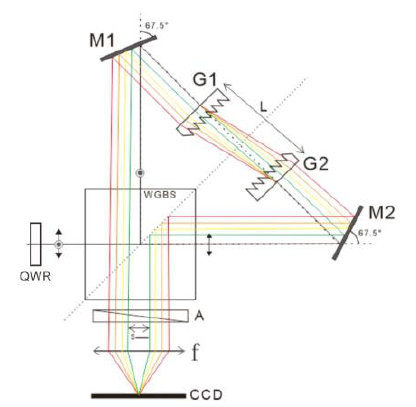
Figure 1. Schematic setup of the modified DCWPSI Where m is the order of diffraction, λ is the wavelength of the incident light, L represents the distance between G1 and G2, and d is the period of the grating.